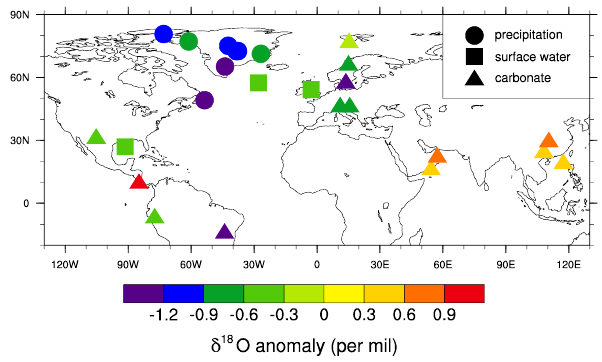
Figure 6. Anomalies in δ 18 O detected using method described in text. Sites plotted here are 2 Fig. 6. Anomalies in δ 18 O detected using method described in text. also provided in Table 3. 3 Sites plotted here are also provided in Table